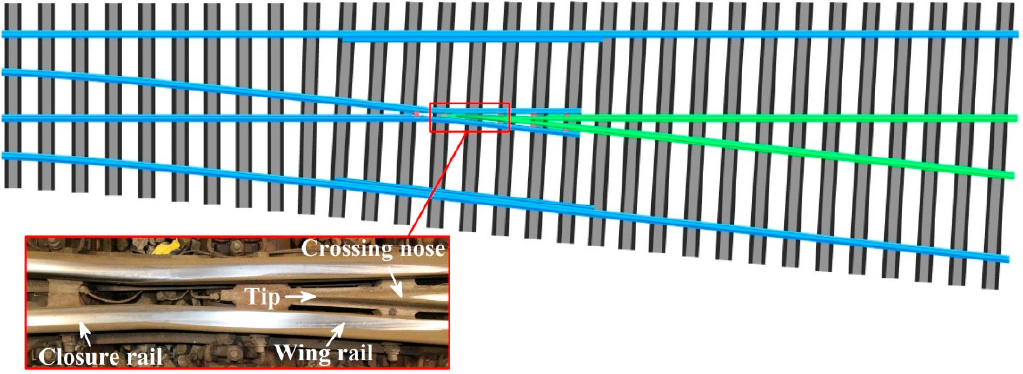
Figure 1. Schematic diagram of a railway crossing.